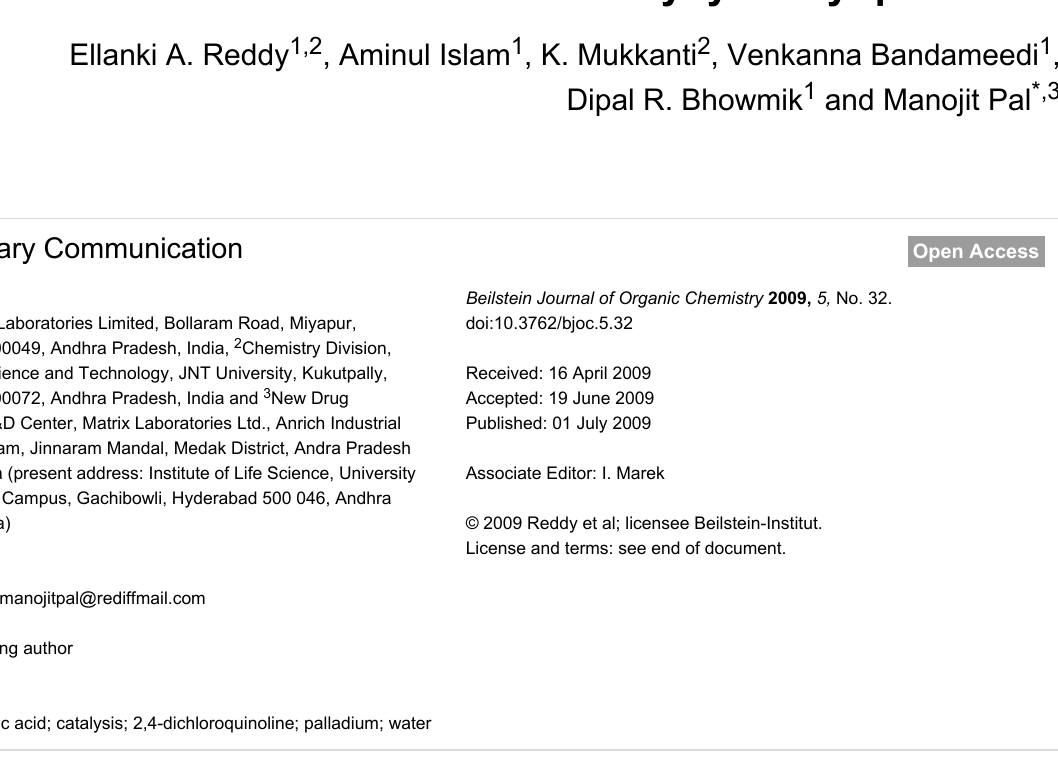
2-Alkenyl/alkynylquinolines, have been reported to